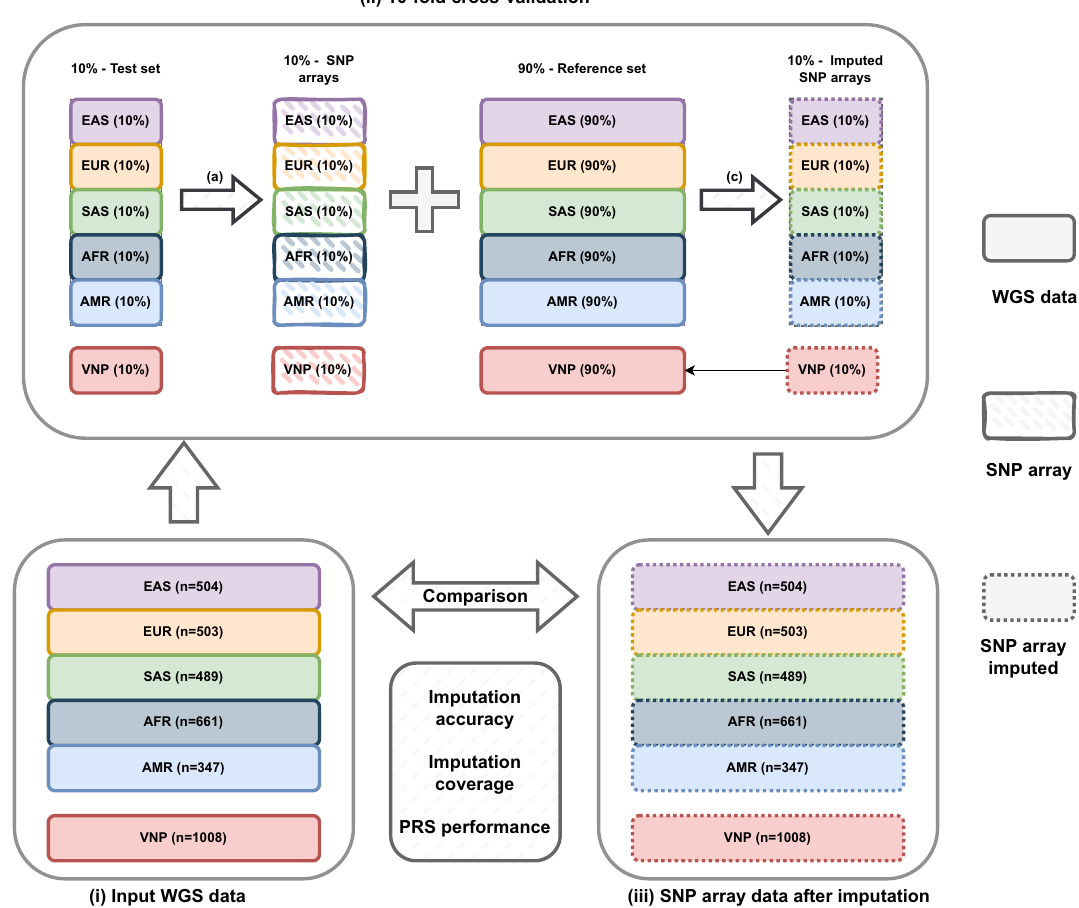
Figure 1. Overview of evaluation pipeline. (i) Two input genetic datasets, including the 1KGP and 1KVG were randomly divided into 10 batches that are equally distributed by populations. (ii) tenfold cross-validation procedure. In each turn, variants of 10% samples were extracted based on arrays’ manifest to generate simulated array genotyping data (arrow a) as input for phasing and imputation with the remaining 90% samples used as the reference set to generate the imputed SNP array data (arrow c). (iii) SNP array data after imputation. Imputed SNP array data of 10 batches were merged according to populations after tenfold cross-validation and were then benchmarked by treating the input WGS data as the golden